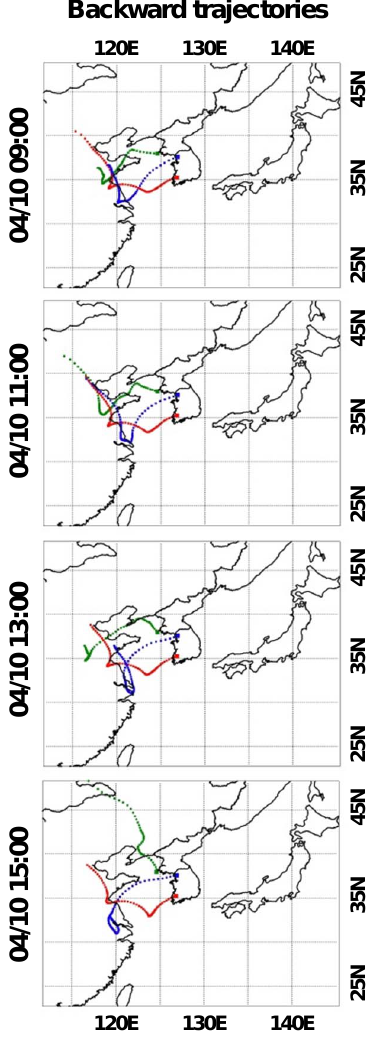
Fig. 4. NOAA HYSPLIT 72h backward trajectory analysis at three Korean AERONET sites (Baengnyeong, Yonsei_Univ (Seoul), and Figure 4. NOAA HYSPLIT 72-hr backward trajectory analysis at 3 Korean AERONET sites Gwangju_GIST) with 2h resolution at 09:00, 11:00, 13:00, and (Baengnyeong, Yonsei_Univ (Seoul), and Gwangju_GIST) with 2-hr resolution at 09:00; 11:00; 15:00LST on 10 April 2011.